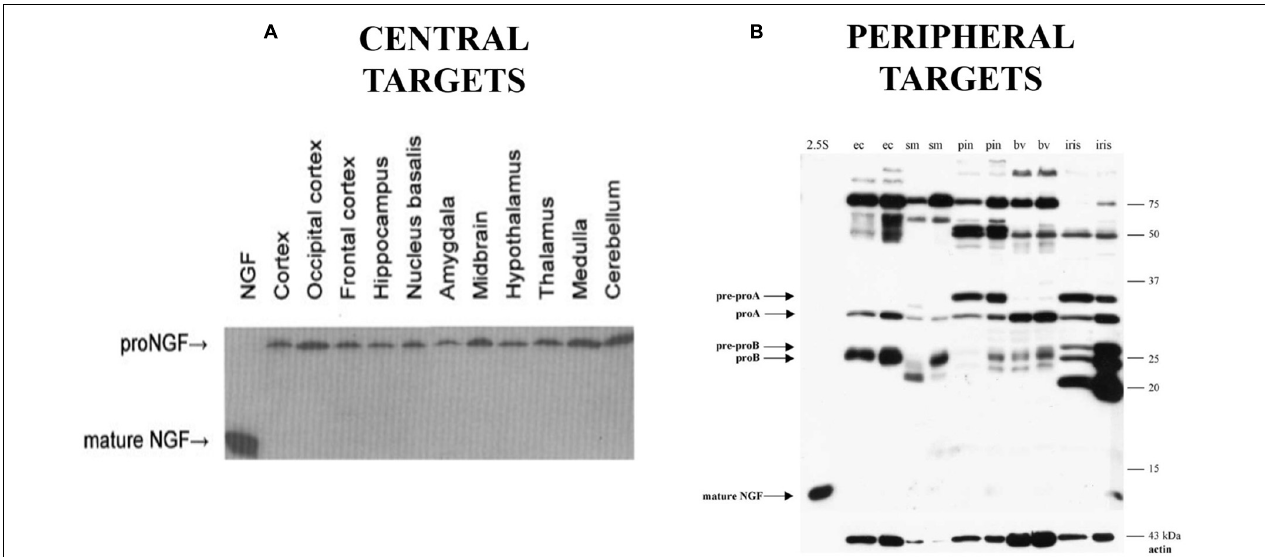
FIGURE 1 | Western blot probing for NGF immunoreactivity in human brain tissue (A) and peripheral targets (B) demonstrating the presence of proNGF and the absence of mature NGF in the indicated areas (ec, external carotid; sm, submandibular gland; pin, pineal gland; bv, extracerebral blood vessels). (A) Reprinted from Fahnestock et al. (2001), with permission from Elsevier. (B) Reprinted from Bierl et al. (2005), with permission from